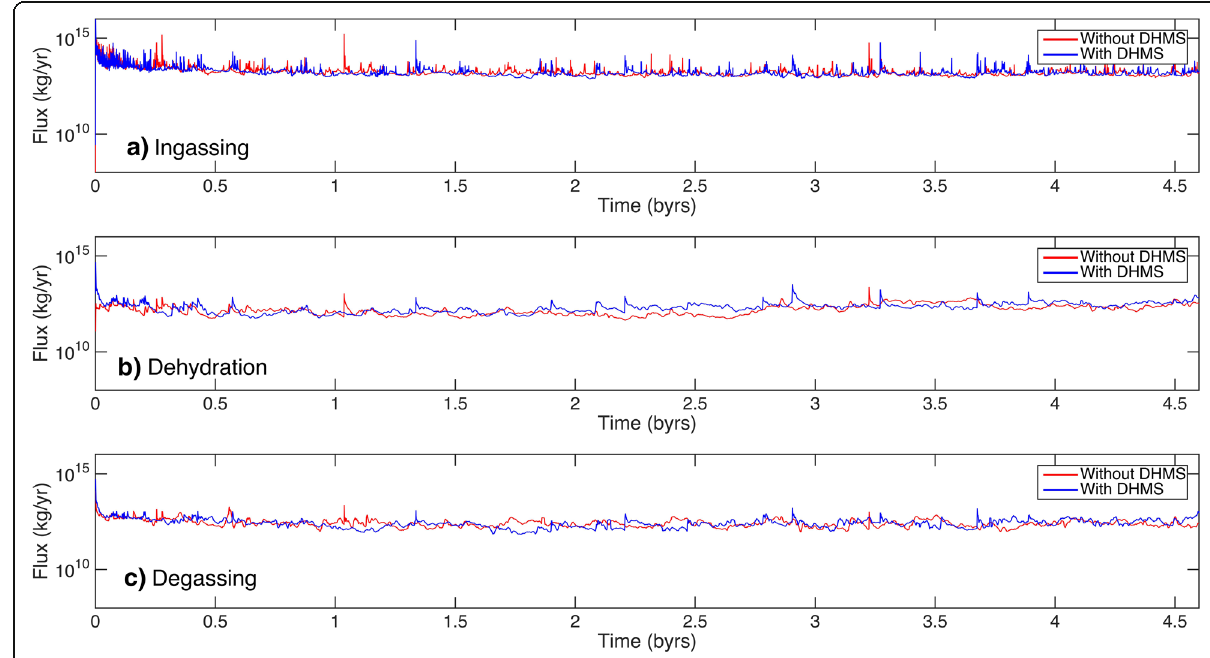
Fig. 5 Water flux diagnostics with and without DHMS solubility as function of time. a Ingassing. b Dehydration. c